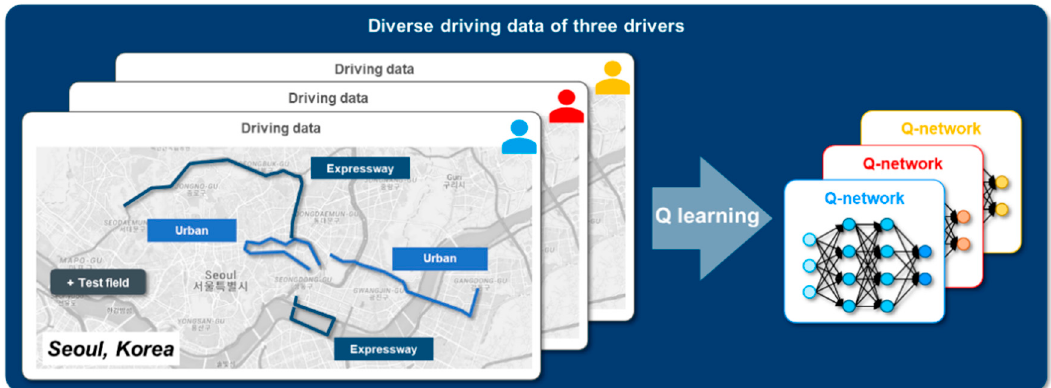
Figure 17. Regeneration control results using driving data.